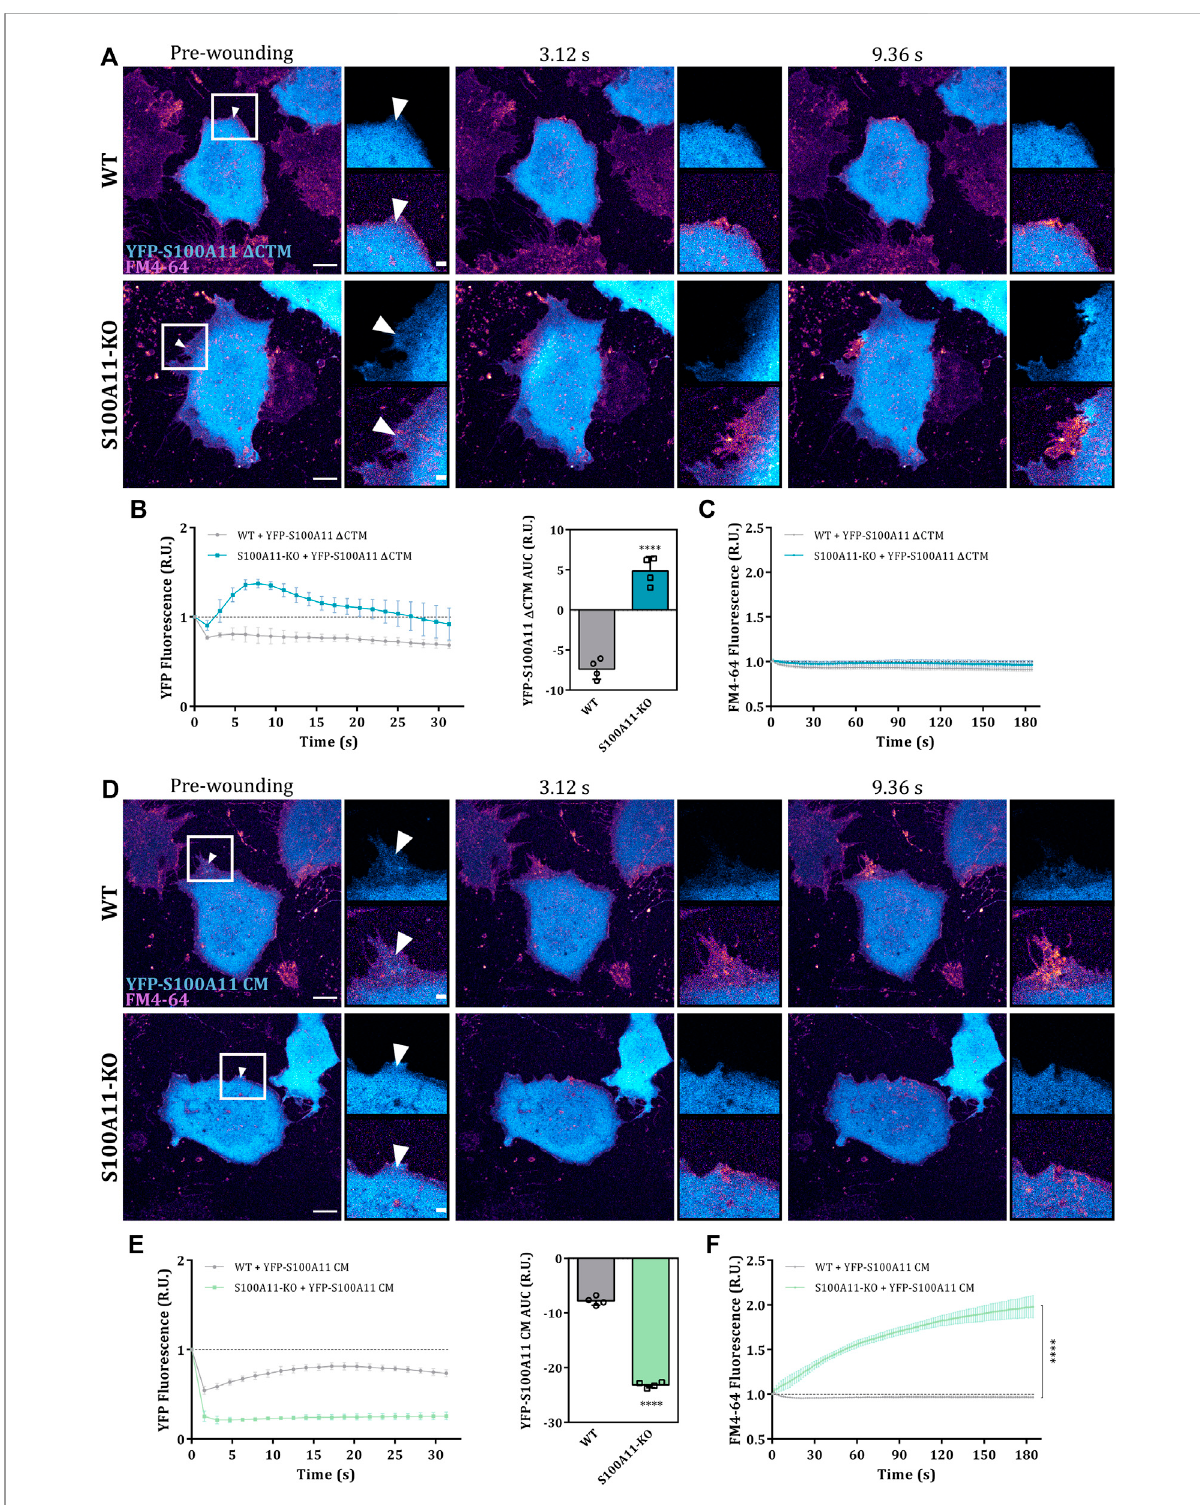
FIGURE 5 The C-terminal extension is dispensable for the function of S100A11 in PM repair. (A) Time-lapse images of S100A11 Δ CTM dynamics in response to laser-induced plasma membrane wounds in WT or S100A11-KO cells, respectively (Supplementary Video S8). YFP-S100A11 Δ CTM expressing cells kept in Tyrode ’ s buffer supplemented with 2.5 mM Ca 2+ and 5 μ g/ml FM4-64 were injured at the lateral membrane edge (white triangles represent the wound sites). Wounding occurred at t = 0; pre-wounding and post-wounding time points are shown. Scale bars